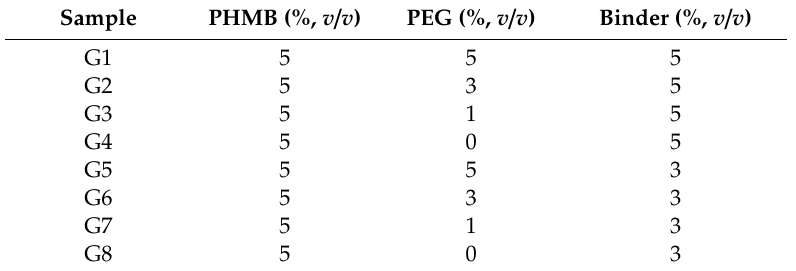
Figure 7. Tearing strength of control and treated samples after 52 washing cycles at 65 °C and 75 °C, Table 5. The di ff erent antibacterial recipes for fabric samples antibacterial warp.